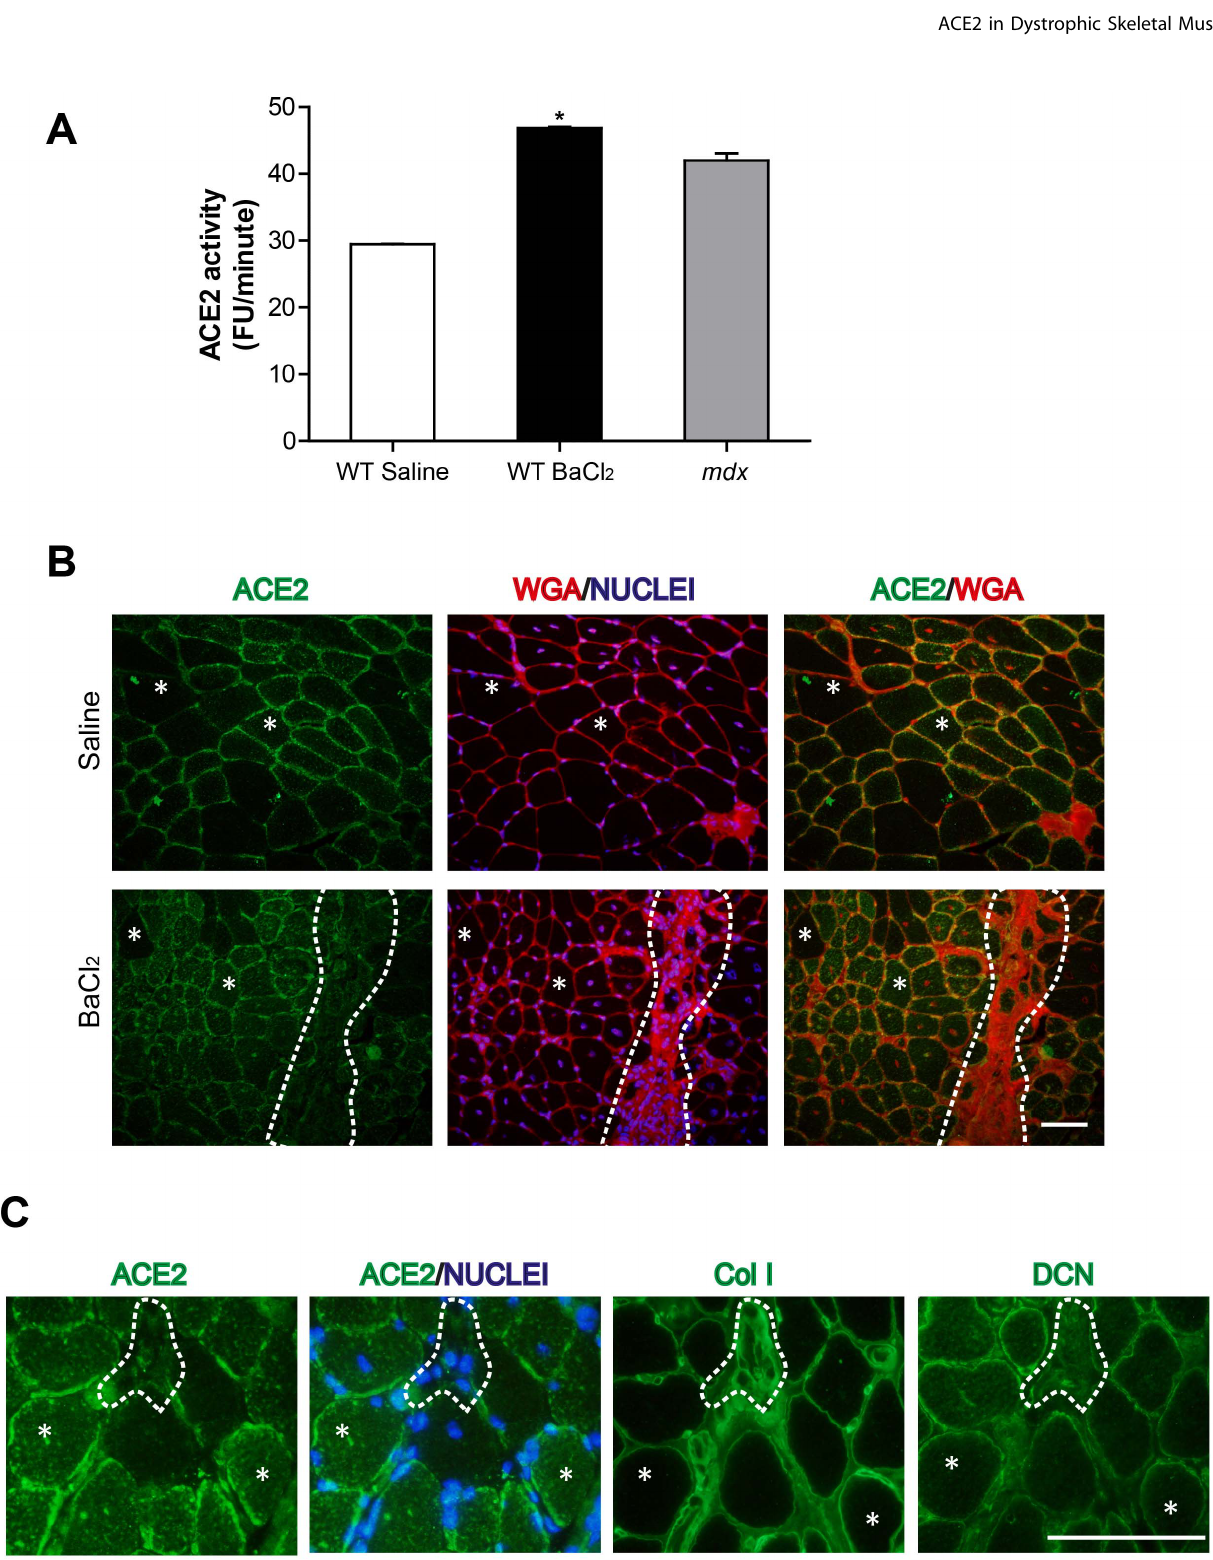
Figure 4. Chronic damage in wt TA increases ACE2 activity. (A) ACE2 activity in extracts from TA injected with saline (WT saline), or with BaCl 2 (WT BaCl 2 ) for 6 weeks, and in mdx TA was measured and the cleavage rate expressed as fluorescence units per minute (FU/min). Each sample contained 50 ug of total protein extract. ANOVA *p , 0.001 vs. wt saline. (B) Staining of ACE2, WGA, and Hoechst in TA injected with saline (Saline) or BaCl 2 (BaCl 2 ) for 6 weeks. The delimitated area shows a fibrotic tissue zone with relatively low ACE2 immunostaining. Asterisks show a single fiber, in which ACE2 immunostaining is mainly localized at the sarcolemma. Bar 50 um. (C) ACE2, collagen I (ColI), and decorin (DCN) immunostaining in TA injected with BaCl 2 for 6 weeks. The delimitated area shows a fibrotic tissue zone with interstitial cells, where ACE2 staining is relatively low. Asterisks show a single fiber in which ACE2 is mainly localized at the sarcolemma. Bar 50 um.